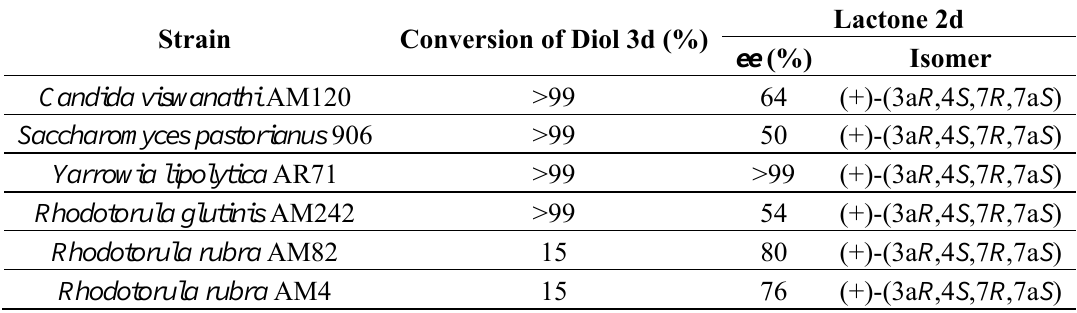
Table 4. The conversion (according to chiral gas chromatography, CGC) after 14 days of diol 3d in the course of screening-scale oxidation conducted in MTP.